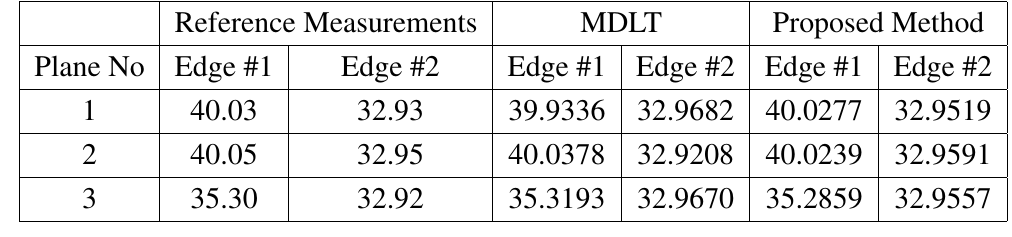
Table 4. Results on the 3D test